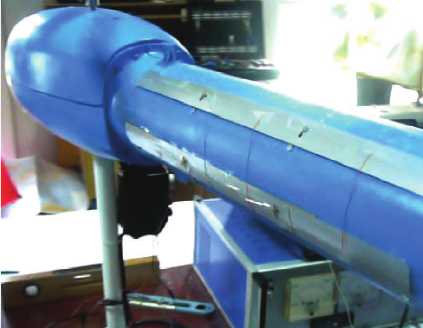
Figure 10: A helicopter structure consists of two main components: a cabin and tail beams of composite materials.